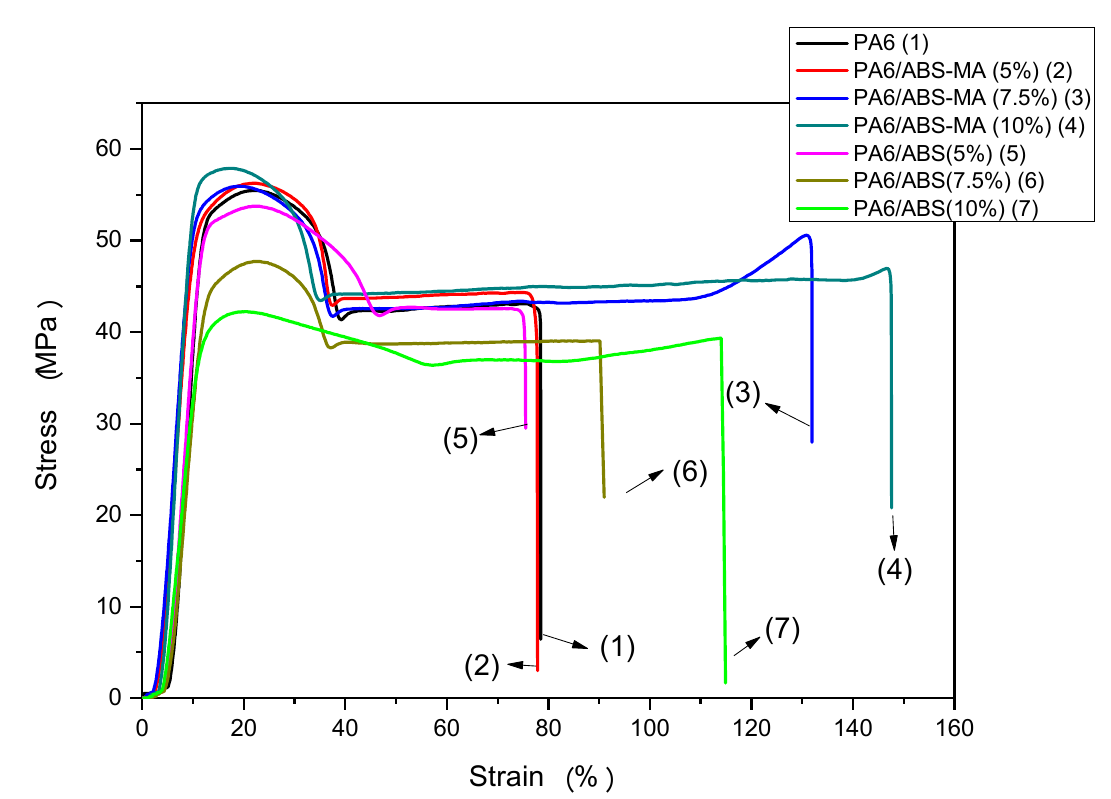
Figure 12. Stress–strain plots of PA6 and the PA6/ABS-MA and PA6/ABS blends,